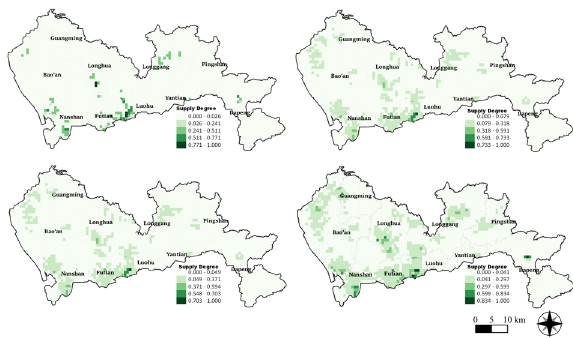
Figure 7. Supply degree of residents' living materials under different extents of